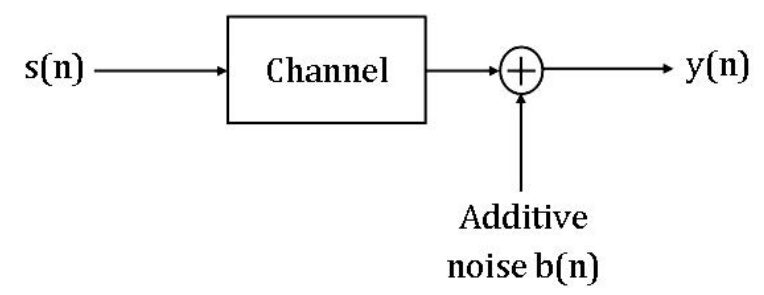
Figure 2. Process to obtain the observed